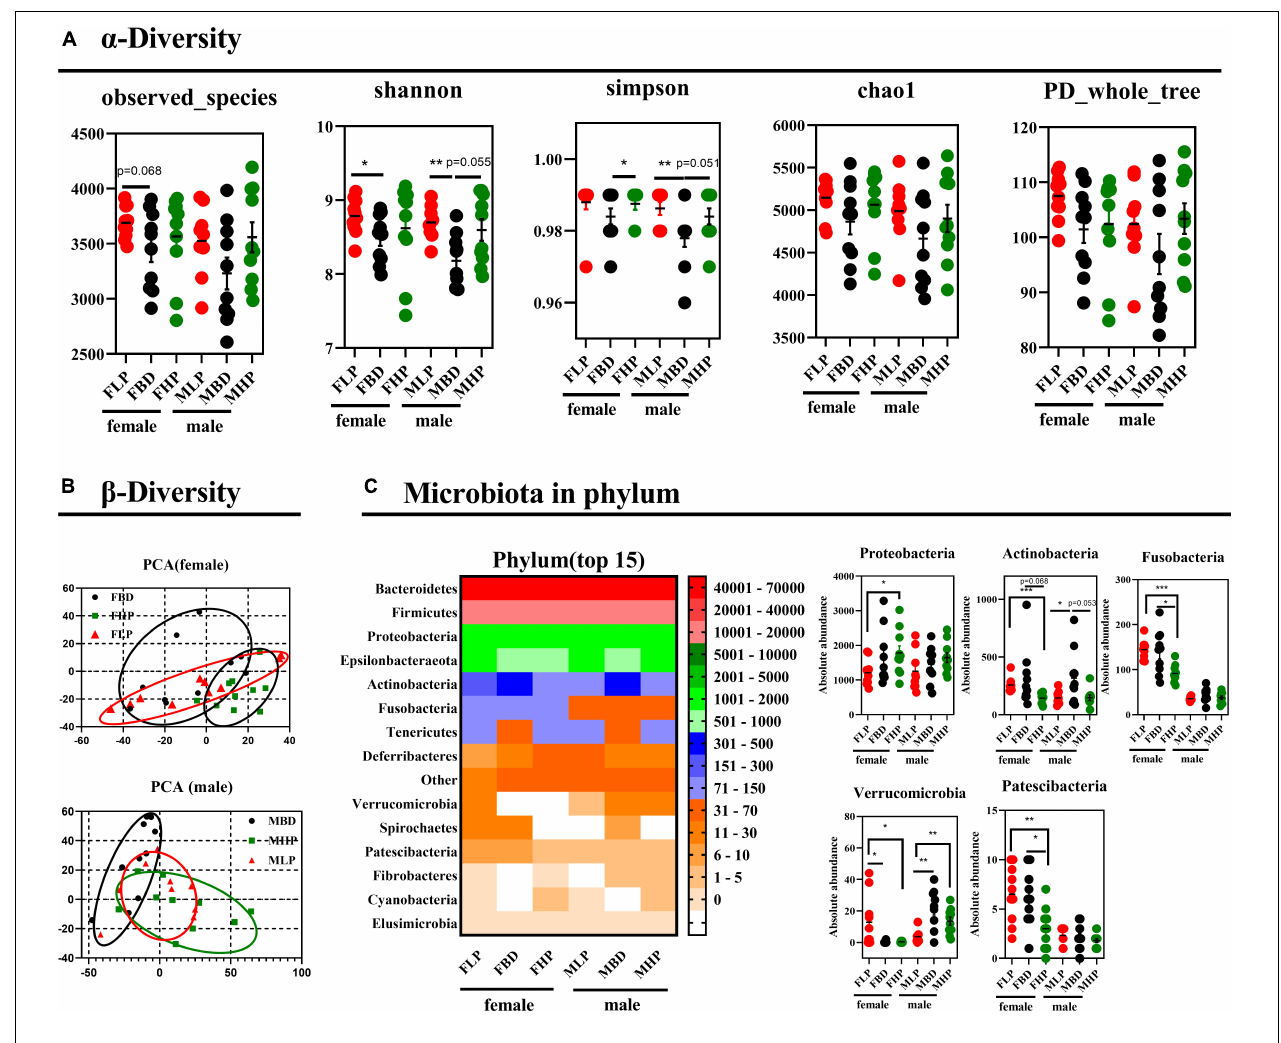
FIGURE 5 | Effects of diets with different protein levels on (A) α diversity, (B) β diversity, and (C) phylum-level bacteria in the fecal microbiota of mice.